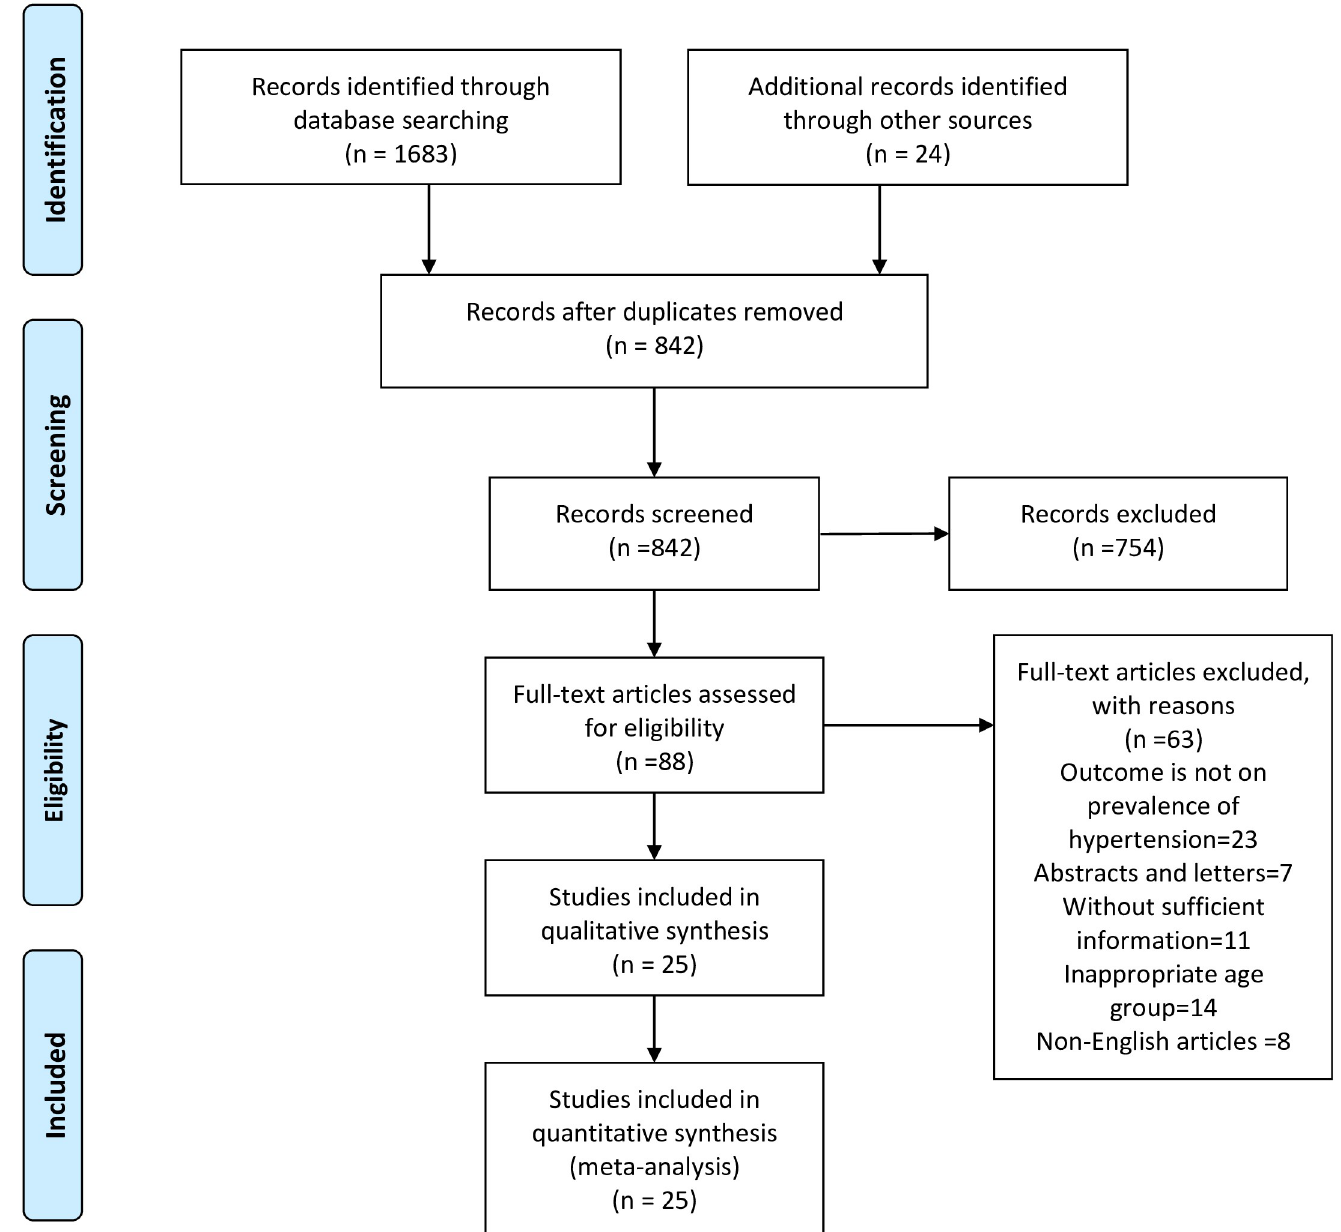
Fig 1. Flow of selection of studies for